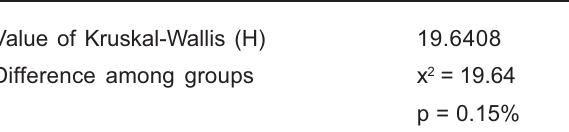
Significant to the level of 1%